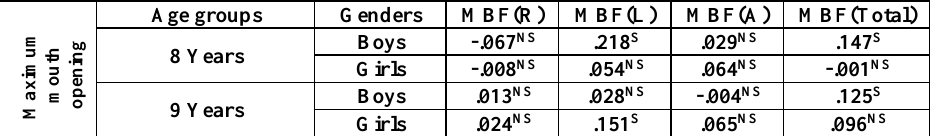
(Significance level=P ≤ 0.05) . Table.3: Pearson correlation coefficient of maximum mouth opening in relation to maximum bite force